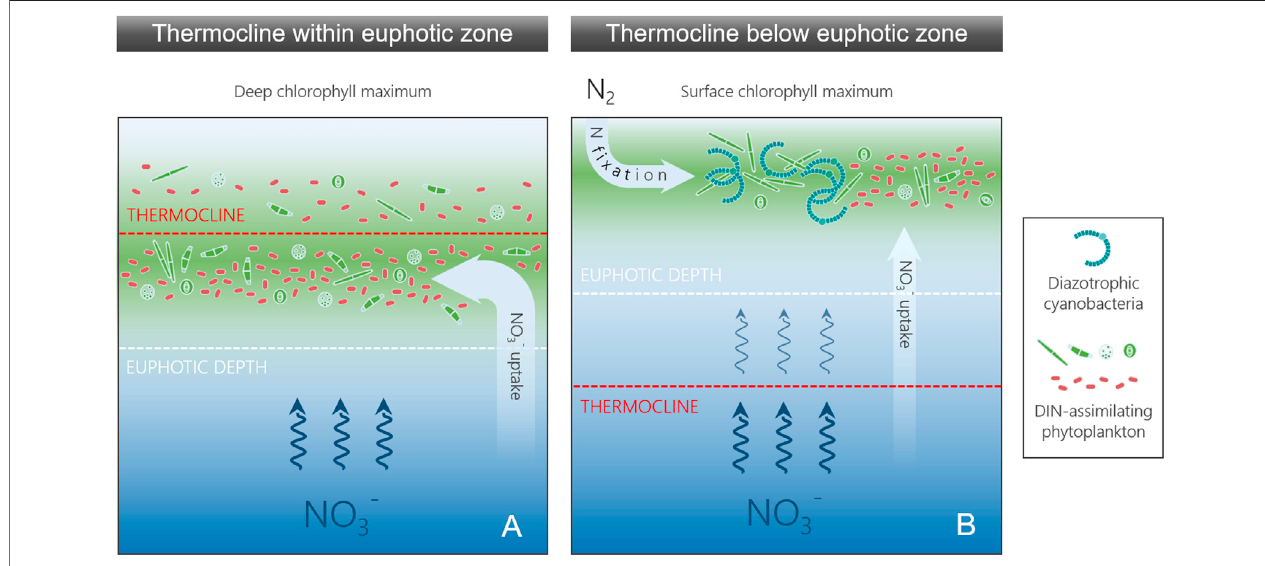
FIGURE 1 | Two conceptual scenarios explaining the abundance of diazotrophic cyanobacteria and chlorophyll a (Chl) concentrations as response to the thermocline location and the euphotic depth in Lake Tanganyika when surface nitrate (NO 3 − ) is depleted and phosphate available. (A) The thermocline is located within the euphotic zone, facilitating a rapid resupply of deep-water nitrate (NO 3 − ). Dissolved inorganic nitrogen (DIN) assimilating phytoplankton outcompete diazotrophic cyanobacteriaandformthesubsurfaceChlpeak,becausetheyarethekeyplayersunderthehighlightandnutrientavailabilityinthelowerpartoftheeuphoticzone. (B) The thermocline is located below the euphotic zone. The reduced supply of deep-water NO 3 − into the euphotic zone creates a favourable environment for diazotrophic cyanobacteria, because they can exploit atmospheric nitrogen (N 2 ) as a N source. Diazotrophs are highly abundant near the water surface resulting in a surface Chl peak.